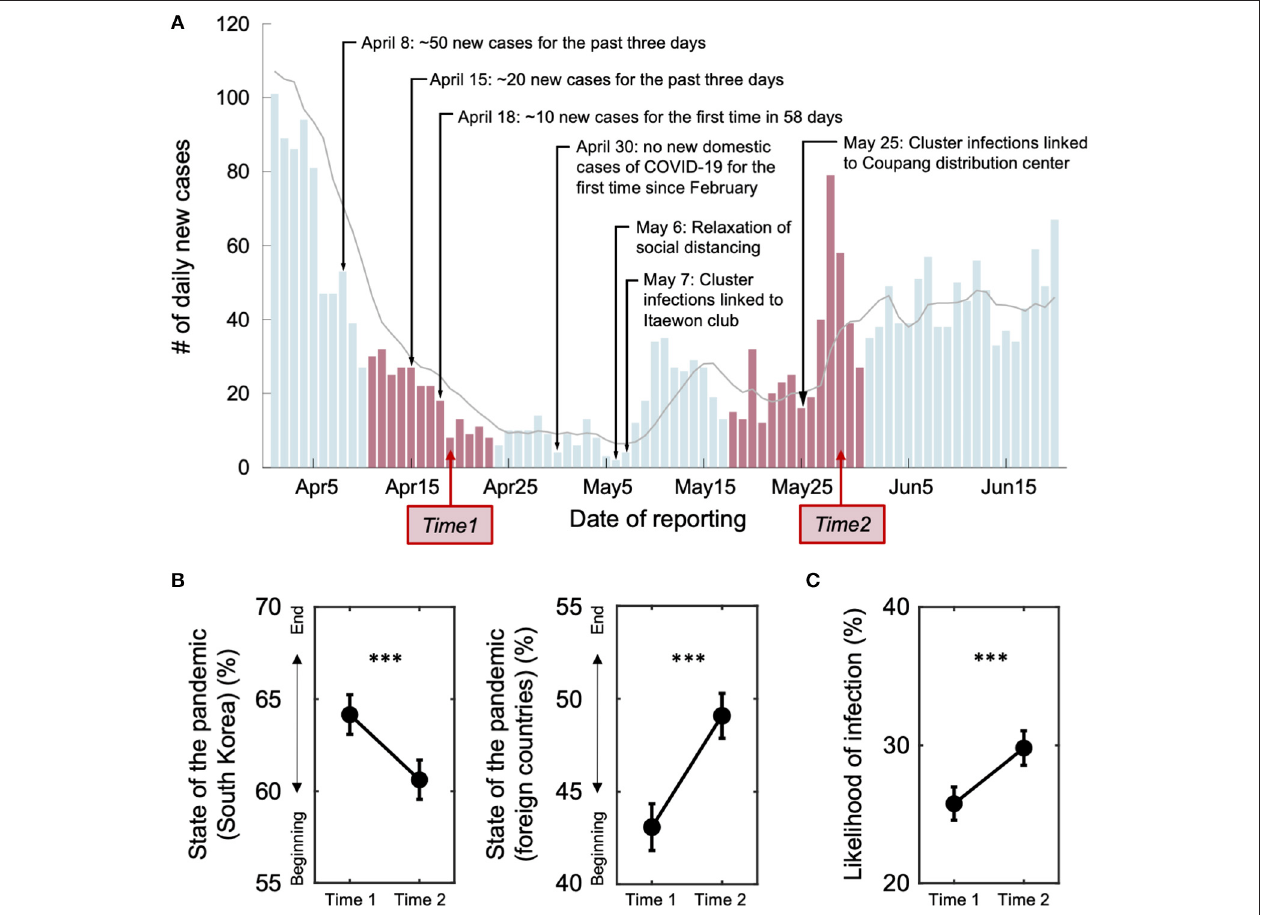
FIGURE 1 | The number of daily new cases of the COVID-19 pandemic in South Korea and the belief changes of individuals between the two time points. (A) The number of daily new confirmed cases of the COVID-19 pandemic reflects objective changes in the epidemic status in South Korea. Major news events about the pandemic are labeled. Note that all events relevant to the COVID-19 pandemic before May 6 are positive, whereas those after the date turned negative. Red bars indicate two time periods of data collection: the Time 1 data was collected during the declining phase of the first wave (between April 14 and 20; Time 1 slope = − 0.91), and the Time 2 data was collected at the beginning of a second wave (between May 21 and 28; Time 2 slope = 0.73). The numbers of new cases were comparable between the two time points. The gray line indicates seven-day moving averages of the number of new cases. (B) At Time 2, people believed that South Korea is further from the end of the pandemic than they expected at Time 1 (temporal distance from the beginning of the COVID-19 pandemic at Time 1 = 64.16 ± 18.58; and at Time 2 = 60.62 ± 18.46). Such a change of belief was specific to South Korea. Participants believed that other countries were getting closer to the end of the pandemic at Time 2 than Time 1 (Time 1 = 43.08 ± 21.89, Time 2 = 49.09 ± 20.83). (C) The belief of individuals about likelihood of themselves being infected increased significantly at Time 2, compared with Time 1 [Time 1 = 25.78 ± 20.83, Time 2 = 29.81 ± 21.41; t (1143) = − 6.42, P = 2.02e-10]. Error bars indicate 95% confidence intervals. *** P <